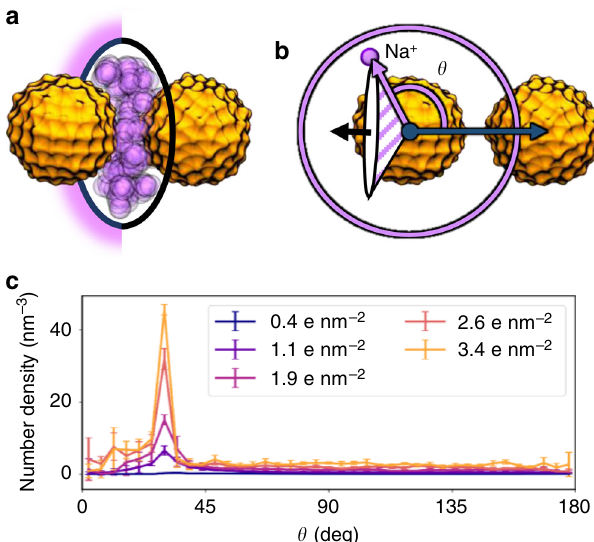
Fig. 3 Counterion distribution upon NP dimerization. a Halo-like cloud of counterions (purple) accumulated at the edge of the two NPs contacting region. Superposition of various frames of the simulations. NPs are colored orange. b The angle θ is formed between the direction connecting the two NPs (CV1) and the position vector from one NP center of mass to a sodium ion. Each value of θ de fi nes a conic volume around the reference NP. c The number density of ions as a function of the polar angle θ . The height of the peak found at ~32° increases with the surface charge density of the NPs. Error bars indicate the standard deviation calculated over trajectory